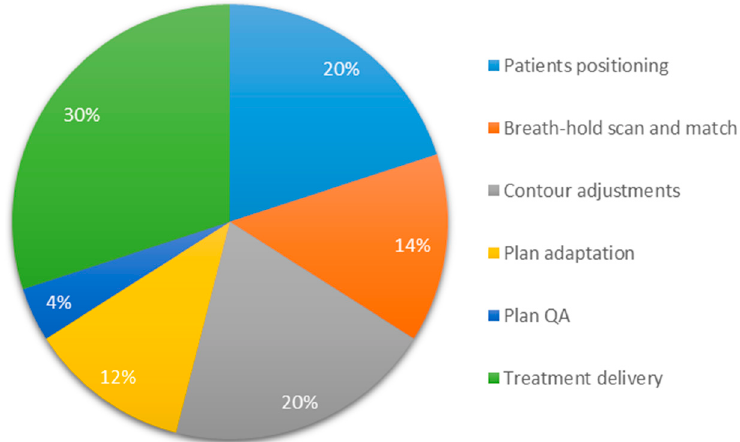
Figure 2. Pie-chart of the average duration of the different components of breath-hold gated adaptive MR-guided radiotherapy with an average time per fraction of 45 min. Table 2. Baseline patient characteristics ( n = 36). Abbreviations: RCC = renal cell carcinoma, GTV = gross tumor volume, PTV = planning target volume, CKD = chronic kidney disease.